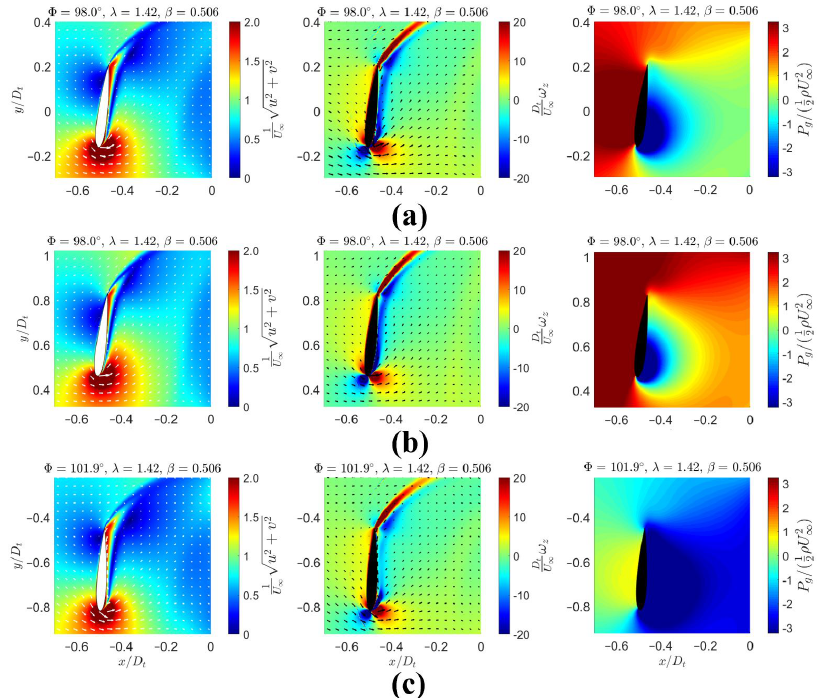
Figure 21. The velocity, vorticity, and pressure fields around one of the turbine blades around its maximum torque angle of the 3 configurations: Single turbine ( a ), forward counter-rotating turbines ( b ), and backward counter-rotating turbines ( c